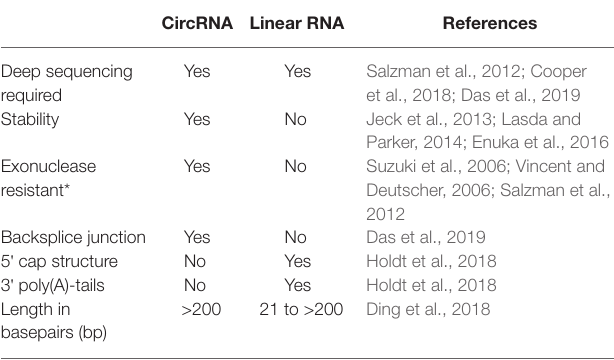
TABLE 1 | Main differences between circular RNAs (circRNAs) and linear